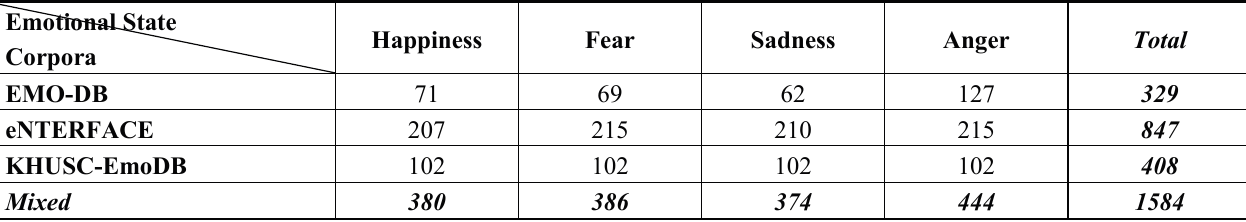
Table 8. Description of the collected speech database.